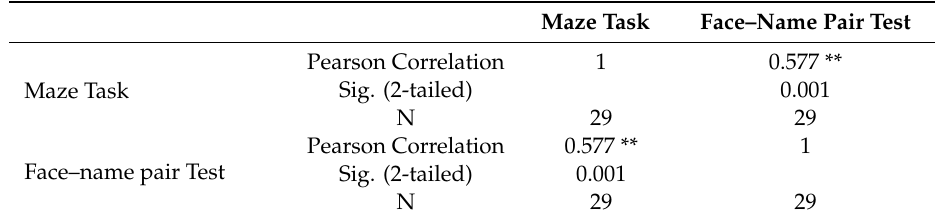
Figure 14. Comparison of memory measurements between the maze task and the face–name pair test in user-controlled mode. Table 4. Correlation between the response accuracy of both the maze task and the face–name pair test (user-controlled mode).